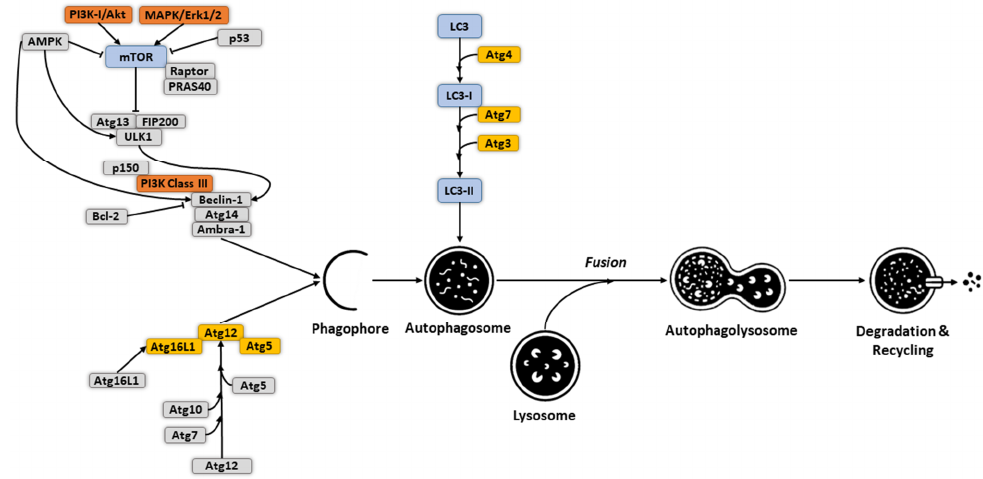
Figure 1. Molecular mechanism of autophagy activation. The kinase mTOR is known as the master regulator of autophagy initiation. In nutrient-rich conditions, the mTOR kinase associates with the ULK1 complex to inhibit the initiation of autophagy. However, under growth factor deprivation, nutrient starvation, or other stimuli, activation of energy sensor AMPK or TP53 (p53) leads to activation of the ULK1 complex and inhibition of mTOR activity through phosphorylation. Phosphorylated ULK1 also promotes phosphorylation of ATG13 and FIP200 subunits and dissociate from mTOR. PI3K class III (PI3KC3), BECN1, ATG14, p150, and AMBRA1, form a protein complex (PI3KC3 complex) and initiates phagophore formation in the proximity of the ER or other membrane sources. ATG5-ATG12 complex and LC3 are involved in double- membrane vesicle (autophagosome) formation, elongation, and closure. A ubiquitin-like reaction involving ATG7 and ATG10 contributes to the conjugation of ATG12 to ATG5, which eventually interacts with ATG16 for generating a “large complex”. While ATG4 cleaves LC3 (a light chain of the microtubule-associated protein) to form LC3-I, the “large complex” acts as a ubiquitin ligase to conjugate LC3-I with the polar head of phosphatidylethanolamine (PE) to produce LC3-II, a process essential for autophagosome formation and cargo recognition. The ATG5-ATG12 complex further interacts with ATG16L1 to establish the ATG12-ATG5-ATG16L1 complex. Autophagosomes are sequentially fused with lysosomes to form autolysosomes, whose contents are subsequently digested by lysosomal hydrolases and released for metabolic